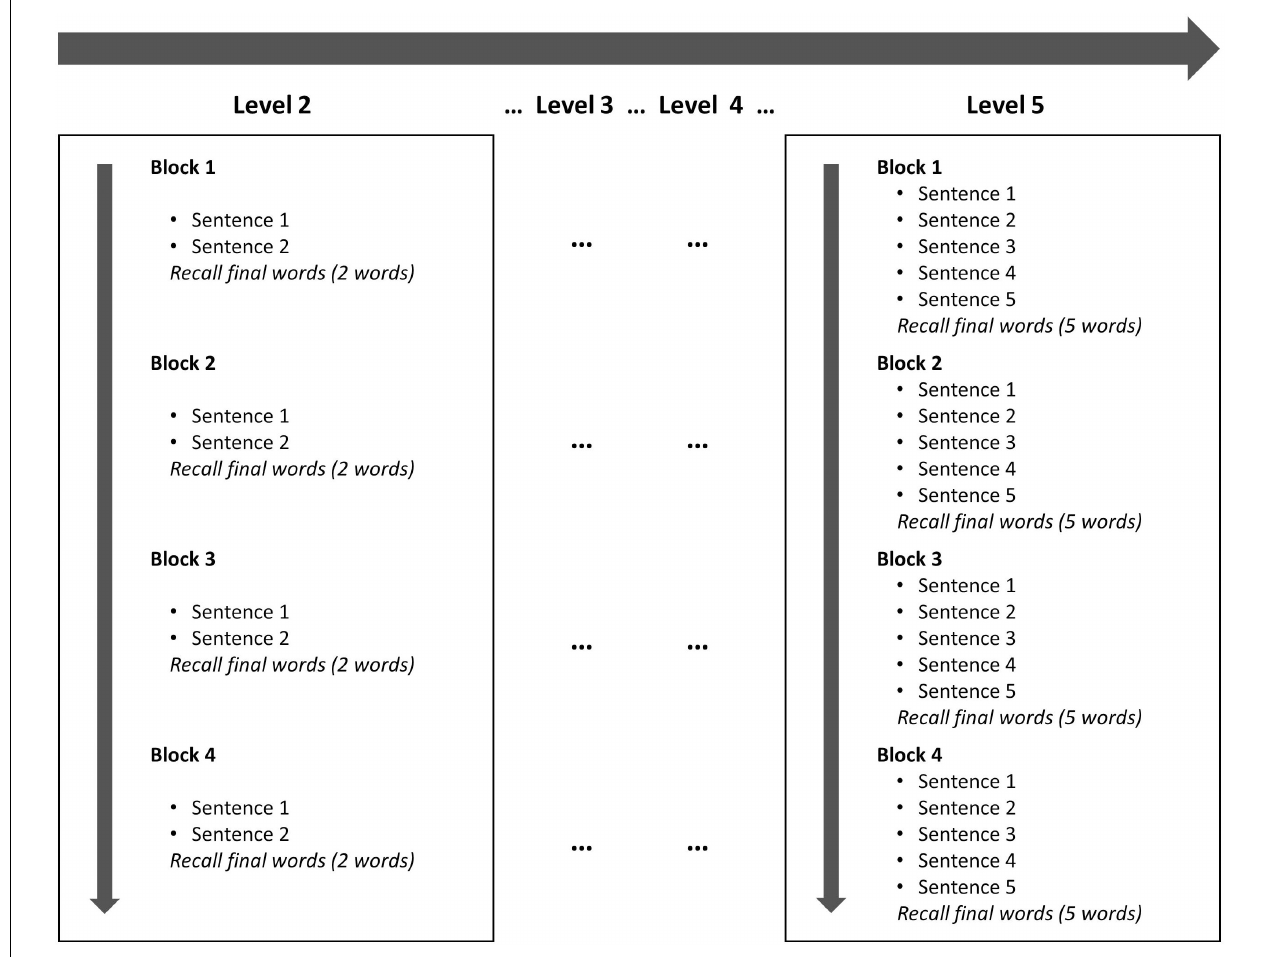
FIGURE 3 | Schematic representation of the load